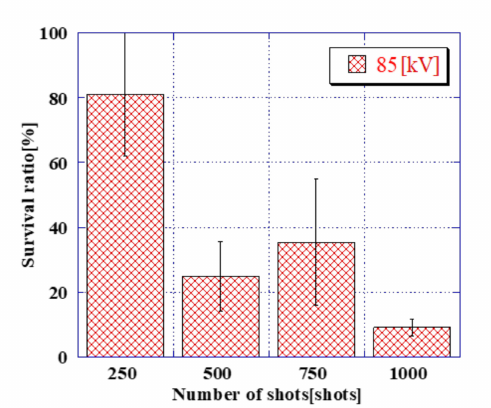
Figure 17. The survival ratios of E. coli after applying plasma of each pulse number in configuration (6) (depth of hollow: 0.5